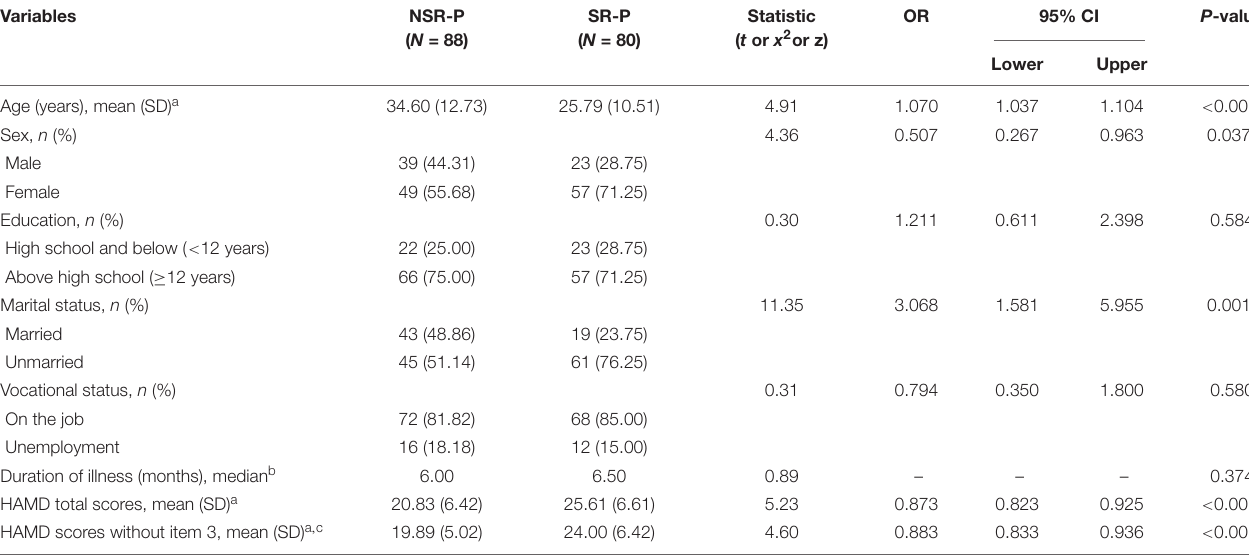
TABLE 3 | Comparisons of demographic and clinical characteristics between the SR-P and NSR-P groups. Variables